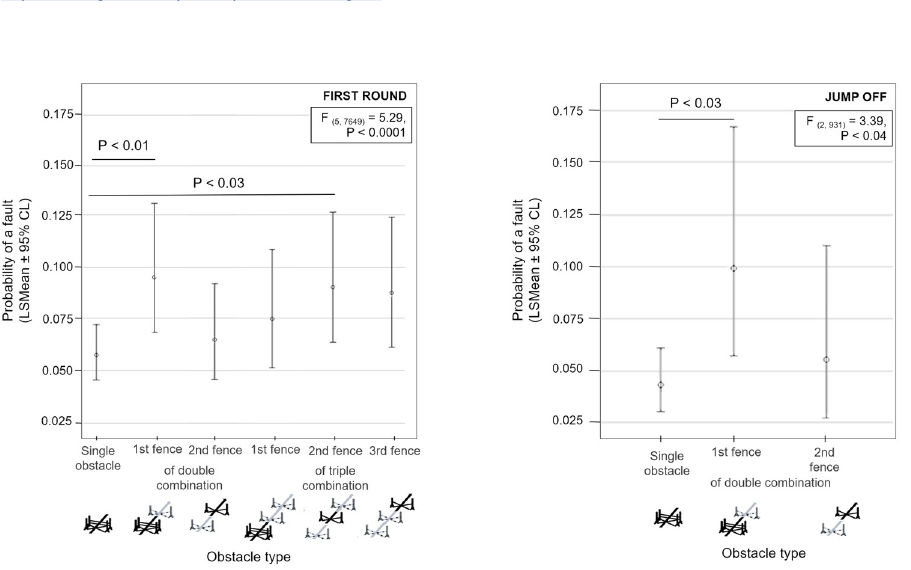
Fig 3. Predicted probability of a fault on single obstacles vs. obstacles in combitation. Predicted probability of a fault on single obstacles vs. obstacles in combitation in the first round (left) and jump off (right, mean values ± 95% confidence limit, GzLMM, PROC GLIMMIX,